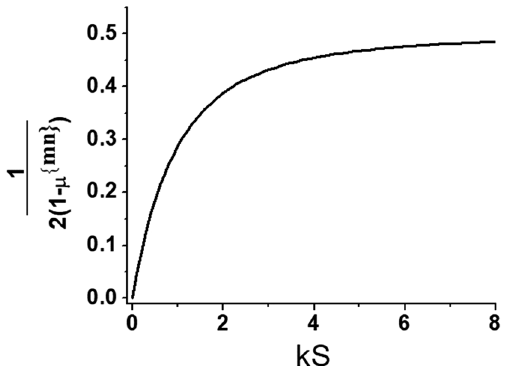
Figure 8. Dependence of the term μ mn characteristic of the forward volume wave on normalized in-plane